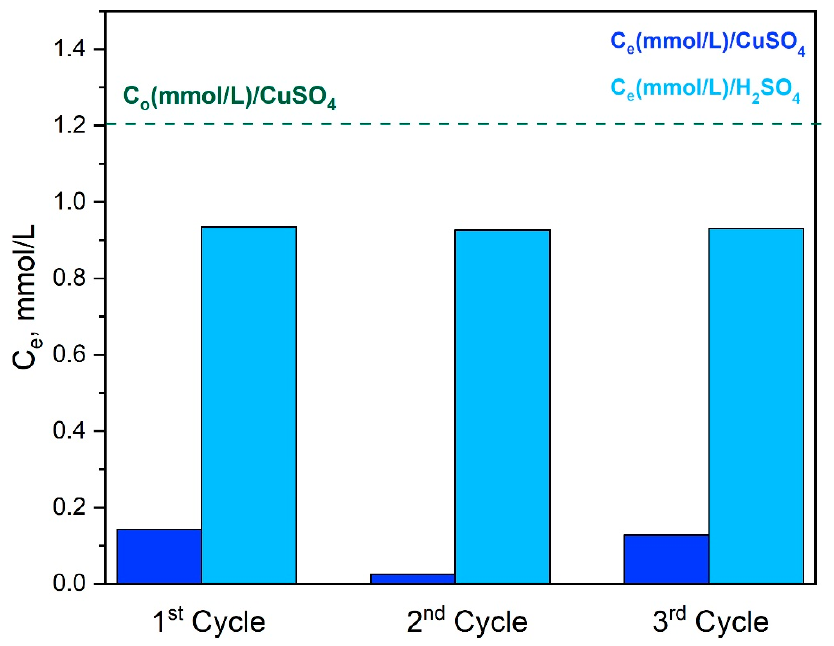
Figure 14. The values of C e (mmol/L) during three cycles of Cu 2+ ions adsorption–desorption study of Ch-NH 2 /P(DMAM-co-GMA) 8:2 membrane.